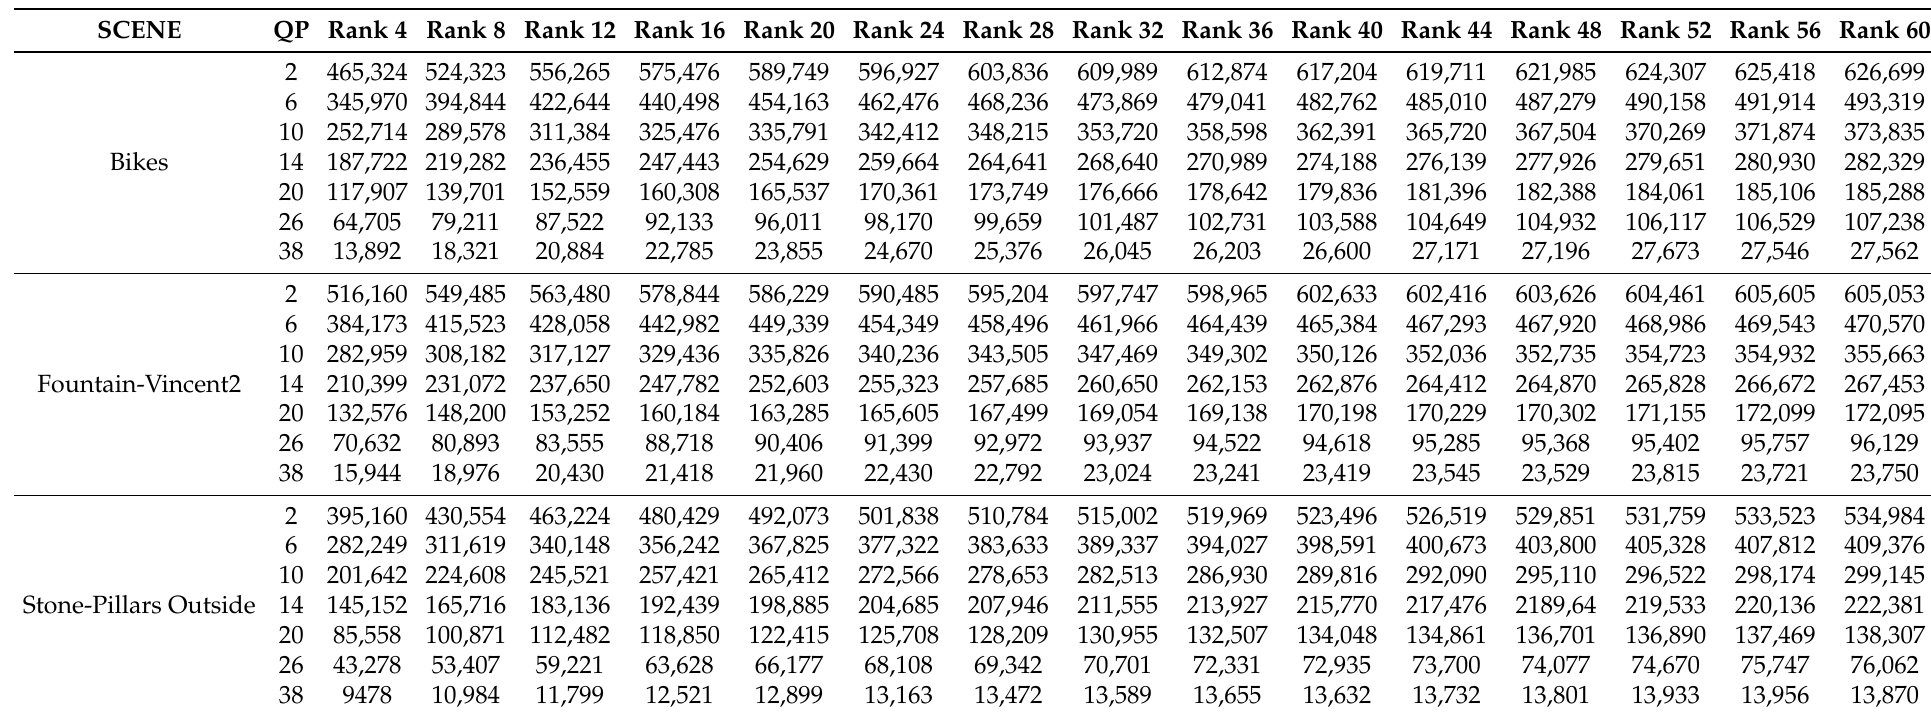
Table 2. The total number of bytes written to file during compression using our proposed scheme for fifteen chosen ranks.